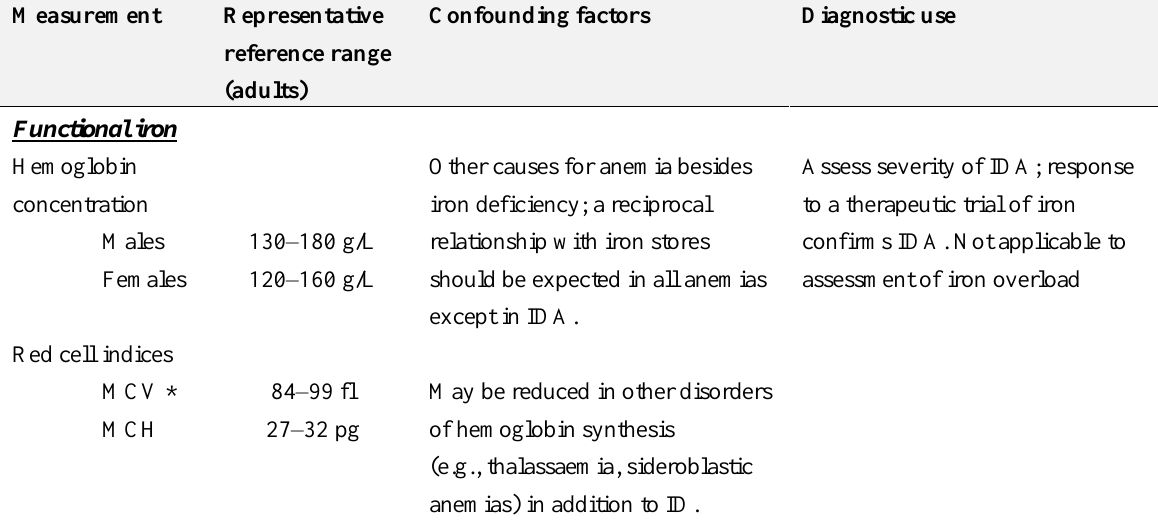
Table 6. Markers used for assessment of body iron status (adapted from BNF